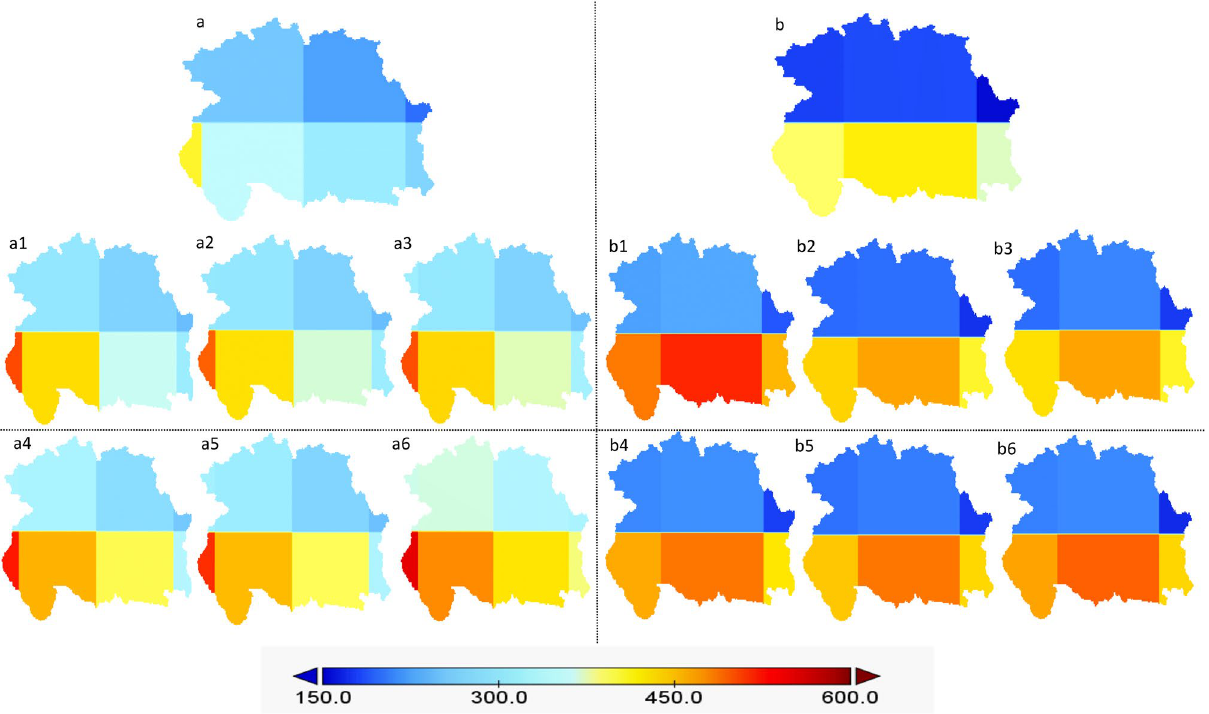
Figure 3. Mean annual basin spatial precipitation (mm) based on ( a ) ECE3-baseline, ( a1 ) ECE3-SSP1-mid- century, ( a2 ) ECE3-SSP2-mid-century, ( a3 ) ECE3-SSP5-mid-century, ( a4 ) ECE3-SSP1-end-century, ( a5 ) ECE3-SSP2-end-century, ( a6 ) ECE3-SSP5-end-century and ( b ) ESM-baseline, ( b1 ) ESM-SSP1-mid-century, ( b2 ) ESM-SSP2-mid-century, ( b3 ) ESM-SSP5-mid-century, ( b4 ) ESM-SSP1-end-century, ( b5 ) ESM-SSP2-end- century, and ( b6 )